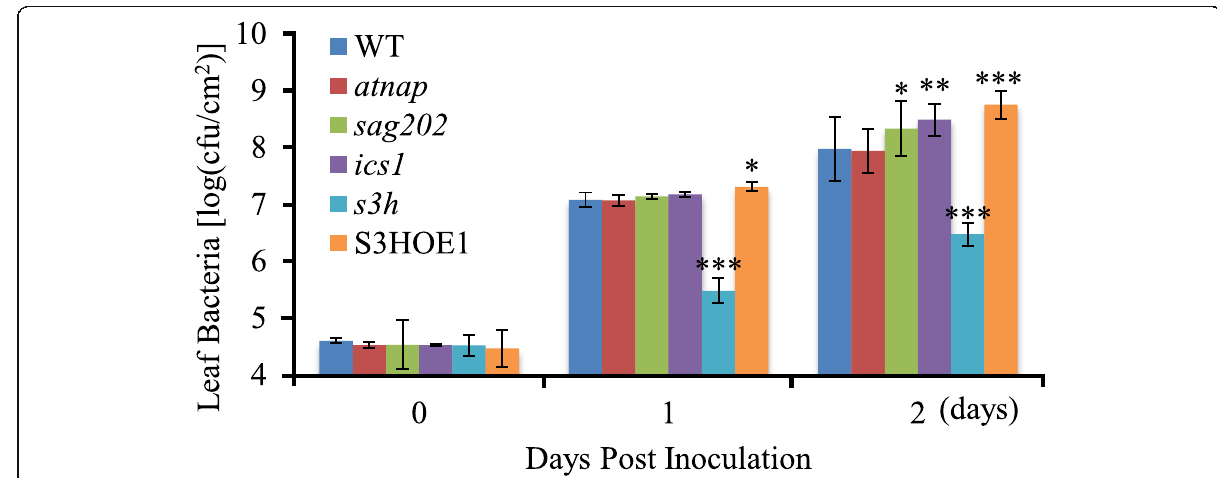
Fig. 7 Growth of P. syringae pv. Tomato DC3000 in leaves of WT, atnap , sag202 , ics1 , s3h null mutants and S3HOE1 transgenic plants. The number of colony-forming units (cfu) per square centimeter of leaf area was determined 0, 1, and 2 days after inoculation. Error bars indicate SD of three biological repeats. *, ** and *** indicate P < 0.05, P < 0.01 and P < 0.001, respectively. Student ’ s t-test was used. The s3h null mutant (resistant to the infection) and S3HOE1 transgenic plants (susceptible to the infection) (Zhang et al., 2013) were included for comparison